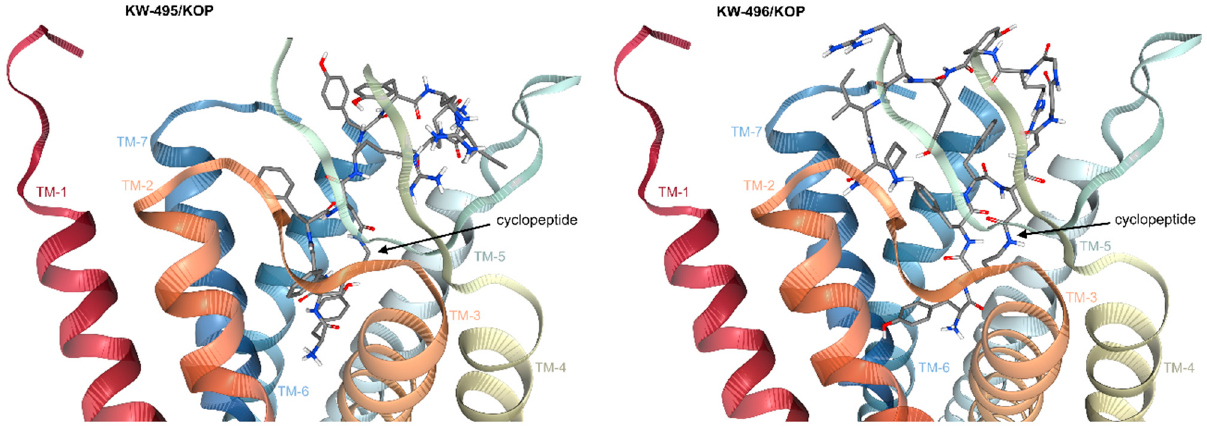
Figure 5. Side views of the predicted complexes of KW-495 /KOP and KW-496 /KOP obtained with the receptor models extracted from PDB ID 6B73. The ligands are rendered in thick lines; C is rendered in gray, N in blue and O in red. Figure obtained with PacDOCK web server [56,57].